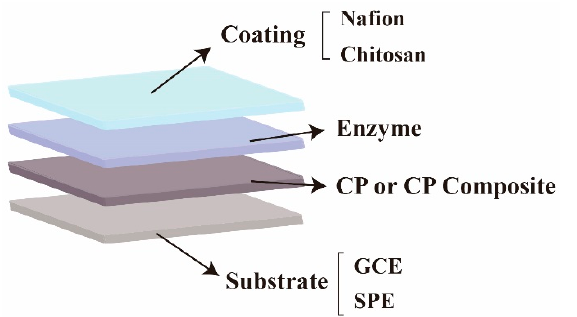
Figure 2. Component architecture of the working electrode based on PEDOT:PSS or its composite for electrochemical detection of H 2 O 2 .